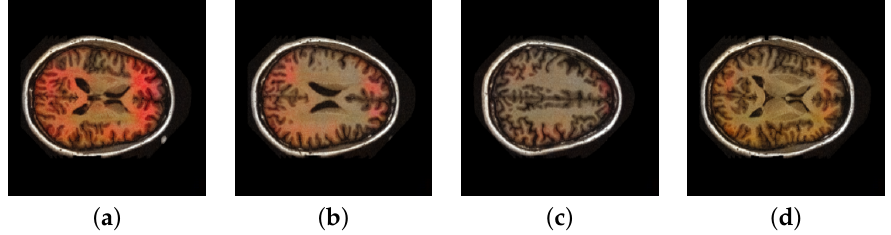
Figure 8. This is the result of Zhang’s method being replicated in our dataset. ( a – d ) are the results of different slices of a patient’s data, and it can be seen that the colors between the slices are not continuous and the colors lose their